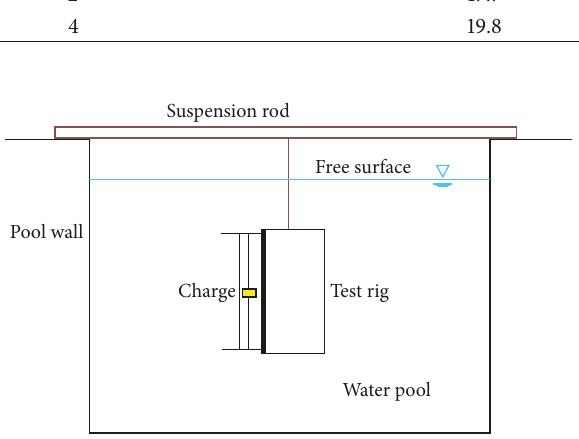
Figure 2: Experimental site layout.